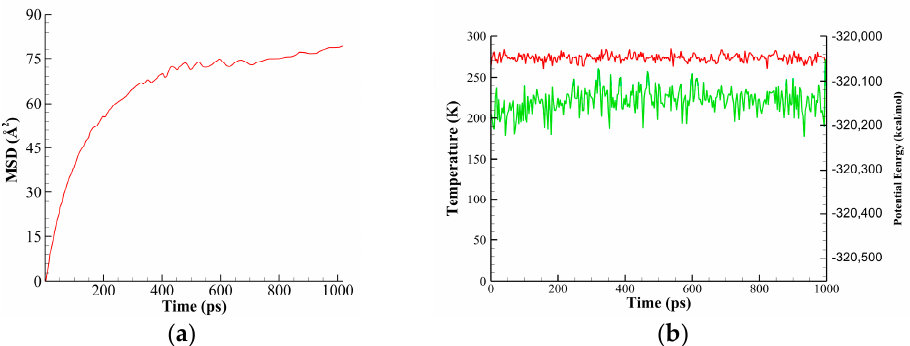
Figure 3. The change of ( a ) mean square displacement (MSD) and ( b ) temperature and potential energy during 1000 ps is shown.